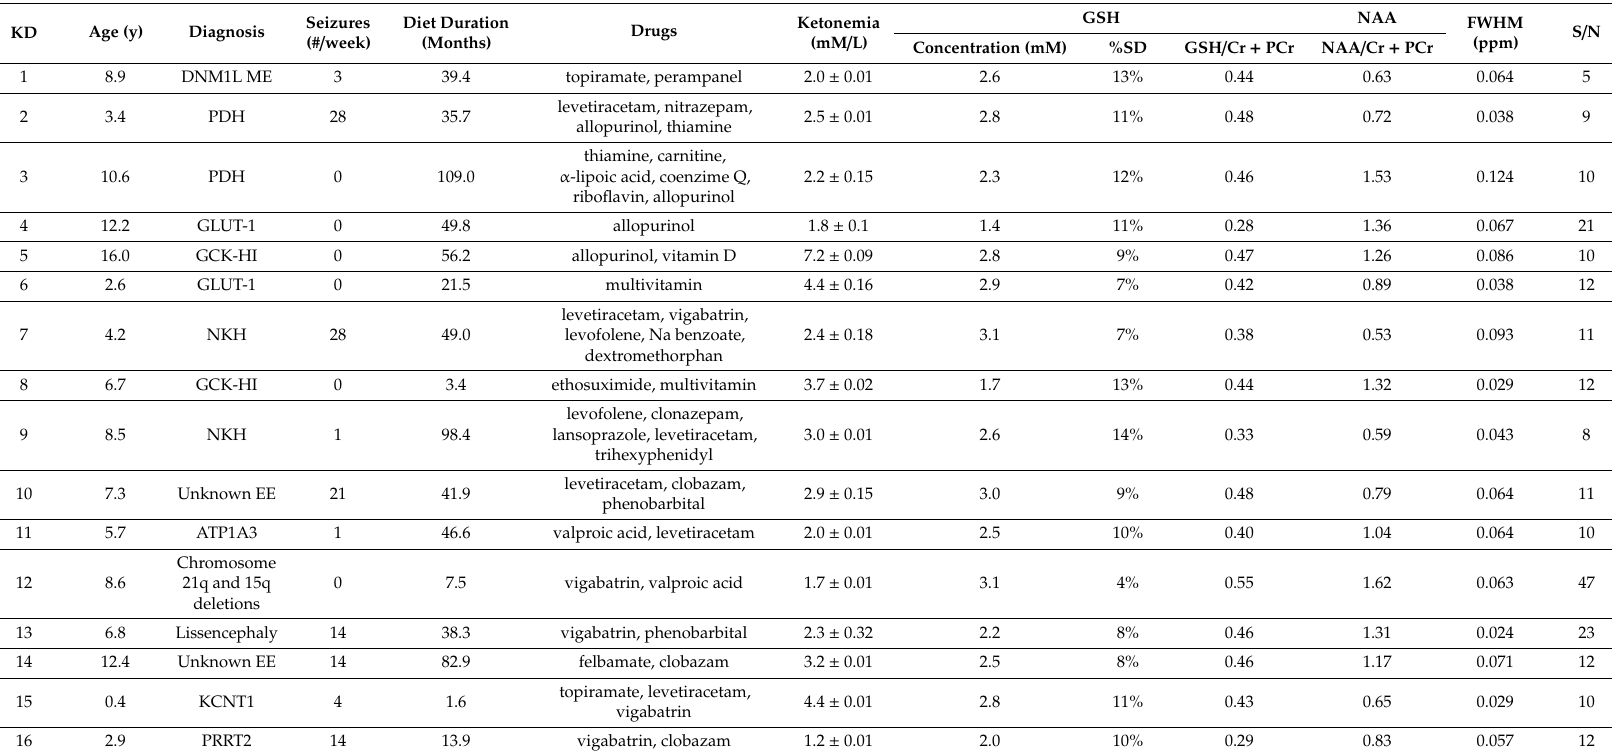
Table 1. Clinical data of KD patients. Abbreviations: GSH / Cr + PCr = Glutathione to creatine / phosphocreatine ratio; NAA / Cr + PCr = N-acetylaspartate to creatine / phosphocreatine ratio; FWHM = Full width at half maximum; S / N = Signal to noise ratio; DNM1L ME = Dynamin-1-like Protein Mitochondrial Encephalopathy; PDH = Pyruvate dehydrogenase deficiency; GLUT-1 = Glucose transporter -1; GCK-HI: Congenital Hyperinsulinism caused by Glucokinase mutations; NKH = Non-ketotic hyperglycinemia; unknown EE = unknown epileptic encephalopathy; ATP1A3 = sodium-potassium ATPase catalytic subunit